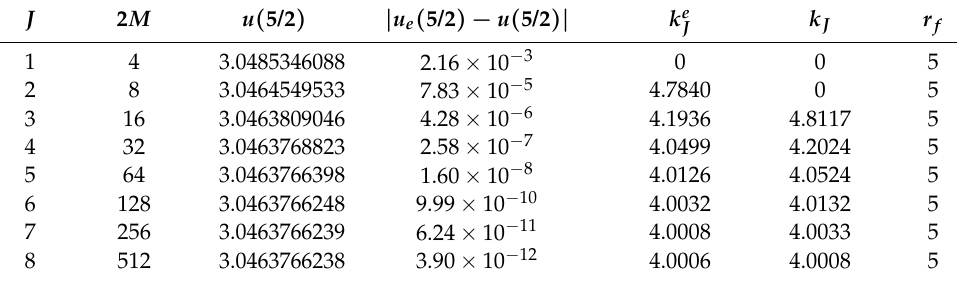
Table 10. Solutions to (25) where u e ( 1/2 ) = 3.046376624 using HOHWM.